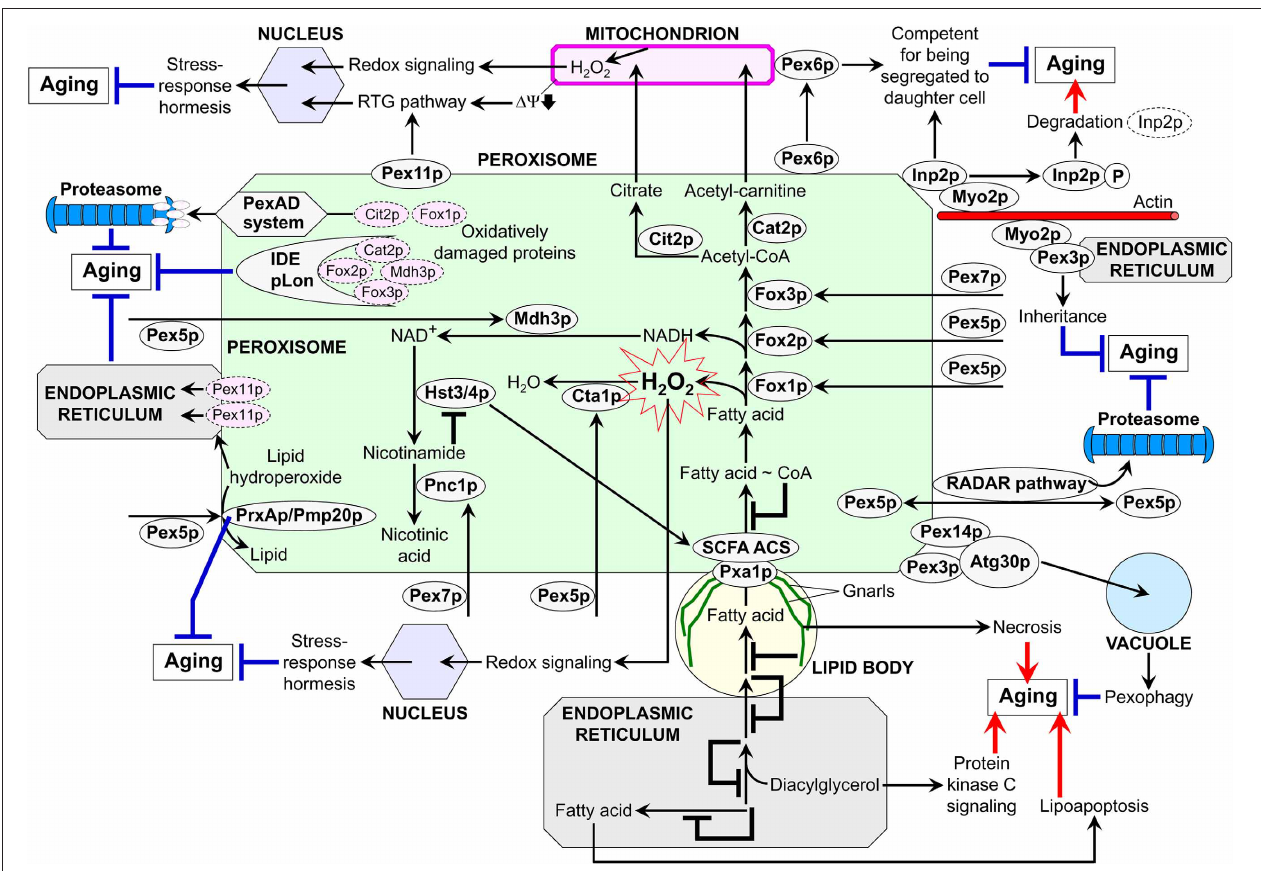
FIGURE 3 | A model for the dynamic integration of peroxisomes into an endomembrane system governing cellular aging. Several mechanisms underlie the essential contribution of peroxisomes to the regulation of cellular aging. Each of these mechanisms relies on a network of communications between peroxisomes and other organelles through the maintenance of the endoplasmic reticulum-peroxisome connectivity, establishment of the extensive physical contact with lipid bodies, exchange of certain metabolites, and/or the bidirectional flow of some of their proteins and lipids. Thus, peroxisomes are dynamically integrated into an endomembranesystem that governs cellular aging. By modulating the dynamics of communication between peroxisomes and other cellular compartments, the age-dependent efficiency of peroxisomal protein import influences a compendium of